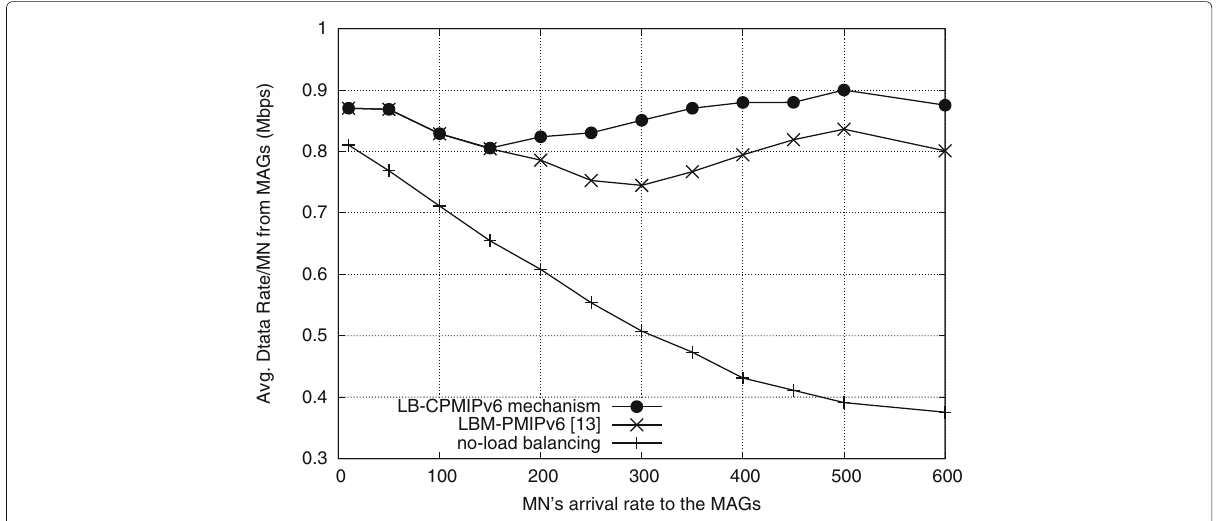
Fig. 17 The transmission rate obtained from the third scenario